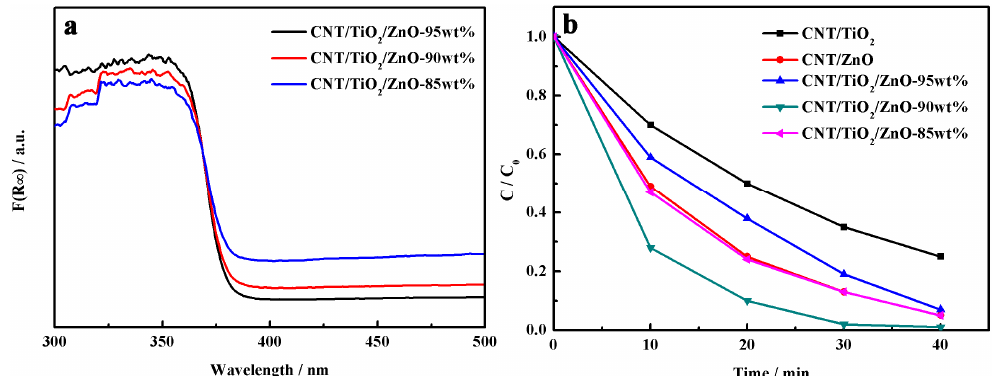
Figure 3. ( a ) UV-vis diffuse reflectance spectroscopy (DRS) patterns of CNT/TiO 2 /ZnO-95 wt %, CNT/TiO 2 /ZnO-90 wt % and CNT/TiO 2 /ZnO-85 wt %; ( b ) change of concentration of rhodamine B (RhB) during degradation process in UV-vis light irradiation of CNT/TiO 2 , CNT/ZnO, CNT/TiO 2 /ZnO-95 wt %, CNT/TiO 2 /ZnO-90 wt % and CNT/TiO 2 /ZnO-85 wt %.